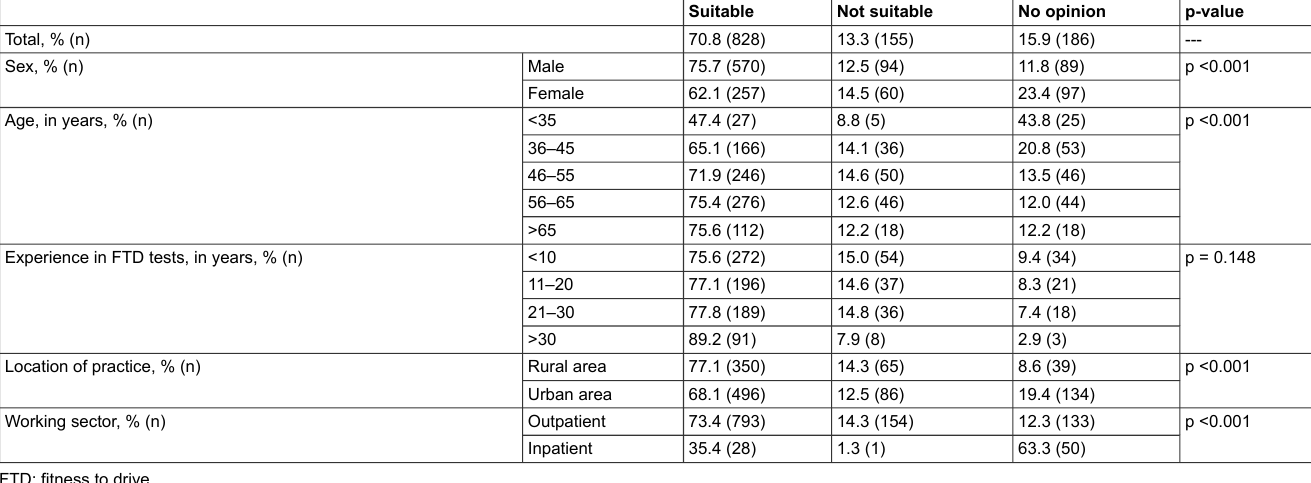
Table 5: Acceptance of level 1 examination as screening instrument for unsuitable